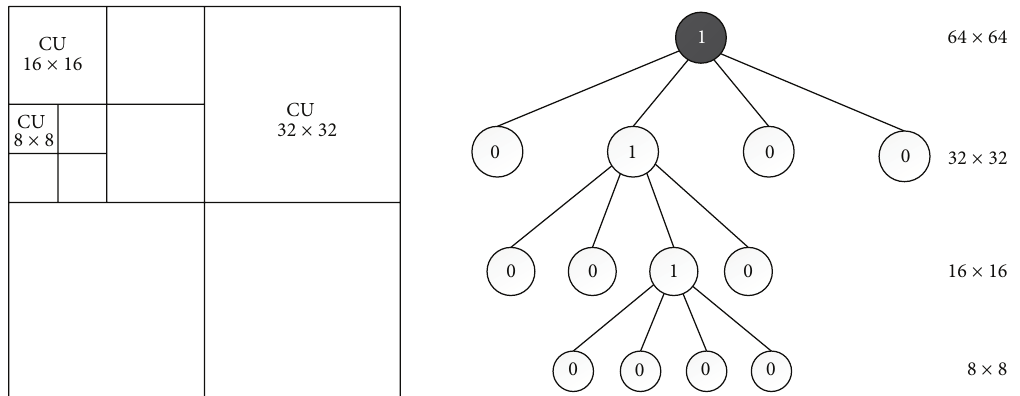
Figure 1: The simple example for recursive